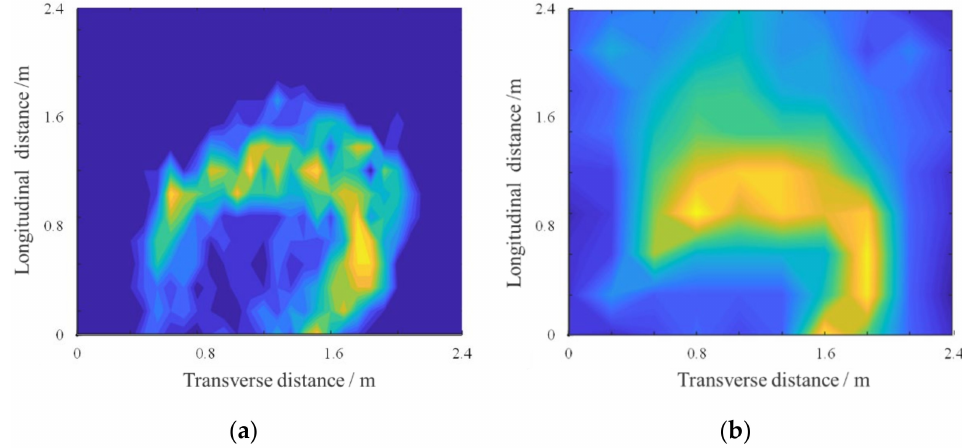
Figure 17. Comparison of simulation test and bench test. ( a ) Result of simulation test; ( b ) result of bench